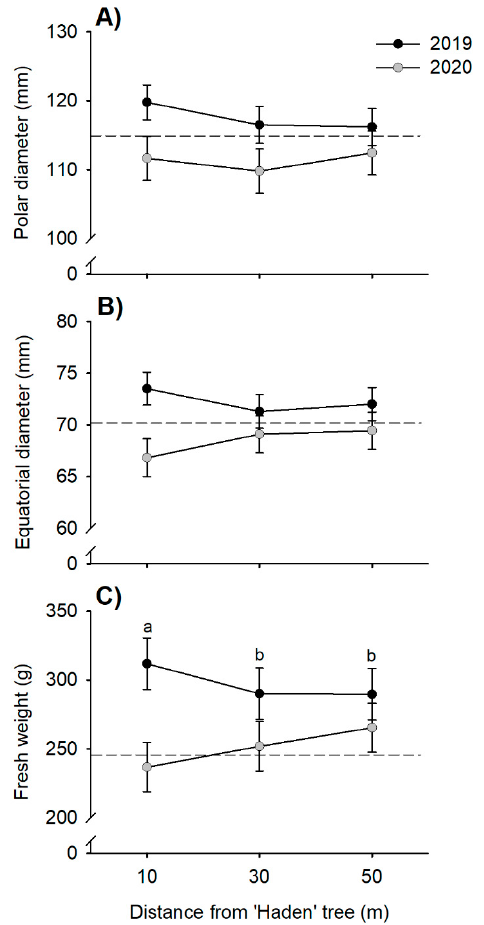
Figure 4. Quality of commercial fruits (mean ± SE) produced in trees of ‘Ataulfo’ located at different distances from trees of ‘Haden’ in 14 orchards (8 in 2019, n = 80 fruits per distance; 6 in 2020; n = 60) of the Costa Grande, Guerrero, Mexico. ( A ) Polar diameter, ( B ) Equatorial diameter, and ( C ) Fresh fruit weight. Dotted lines indicate the average values of ‘Ataulfo’ trees in orchards without ‘Haden’ individuals. Different letters indicate statistical differences according to GLMM and Tukey test ( p < 0.05).